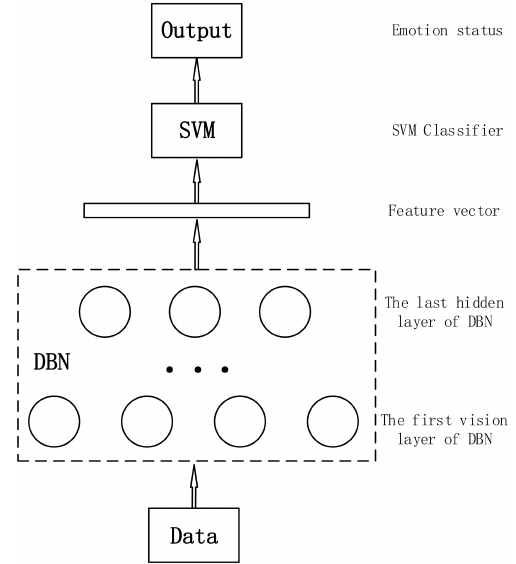
Figure 4. Structure of combining support vector machine (SVM) and DBN. Speech features are converted into deep features by a pre-trained DBN, which are feature vectors output by the last hidden layer of the DBN. The feature vectors act as the input of SVM and are used to train the SVM. The output of the SVM classifier is the emotion status corresponding to the input speech